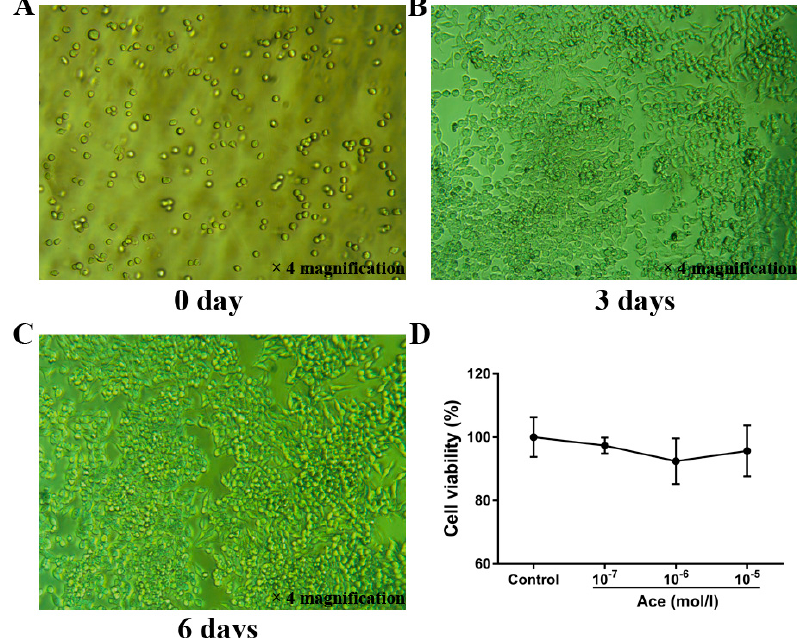
Figure 5. Acteoside treatment on RAW 264.7 cells. ( A ) RAW264.7 cells were incubated without MCSF (30 ng/mL) and RANKL (25 ng/mL). ( B ) RAW264.7 cells were incubated with MCSF (30 ng/mL) and RANKL (25 ng/mL) for 3 days (no treatment with acteoside). ( C ) RAW264.7 cells were incubated with MCSF (30 ng/mL) and RANKL (25 ng/mL) for 6 days (no treatment with acteoside). ( D ) Effects of acteoside on the cell viability of RAW264.7, cells were treated with the indicated concentrations of acteoside for the indicated times. Cell viability was determined by the MTT method.